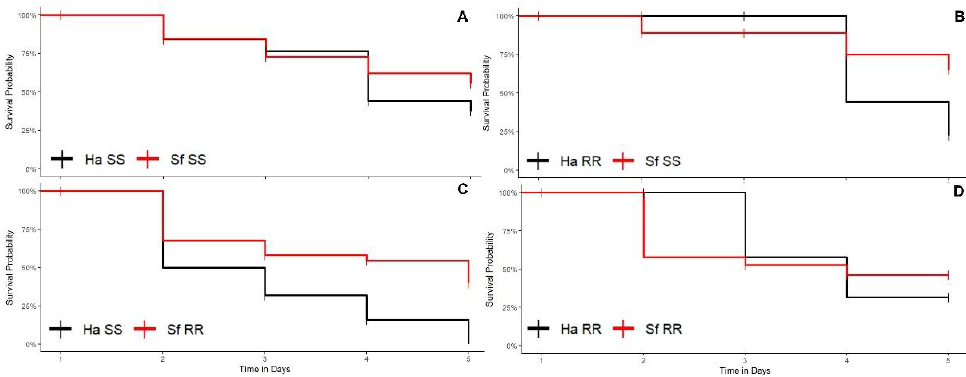
Figure 4. Larval survival curves of insecticide-susceptible (SS) and insecticide-resistant (RR) strains of Helicoverpa armigera (Ha) and Spodoptera frugiperda (Sf) maintained in competition in corn plants. ( A ) Ha-SS versus Sf-SS interaction; ( B ) Ha-RR versus Sf-SS interaction; ( C ) Ha-SS interaction with Sf-RR; and ( D ) Ha-RR interaction with Sf-RR.